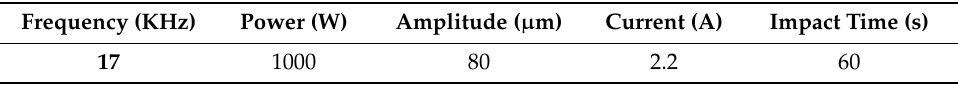
Table 3. Parameters of the UPT.